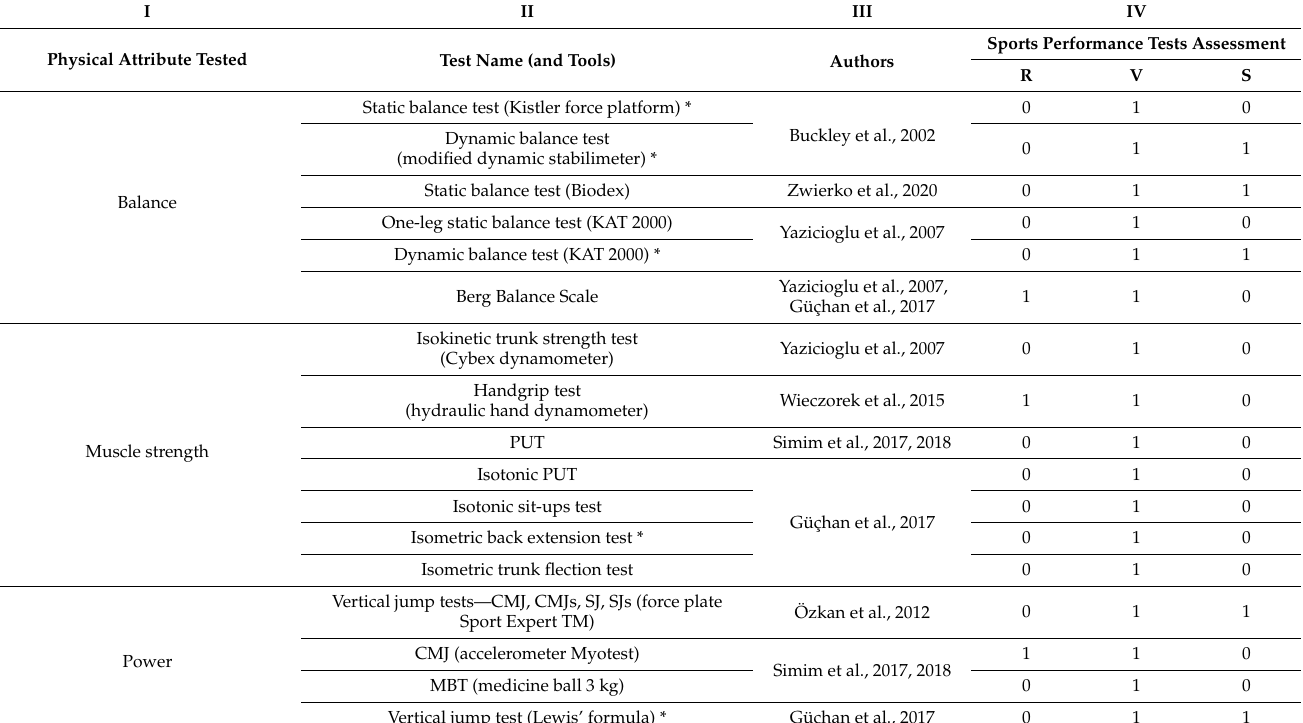
Table 3. Quality assessment of sports performance tests in the review ( n =